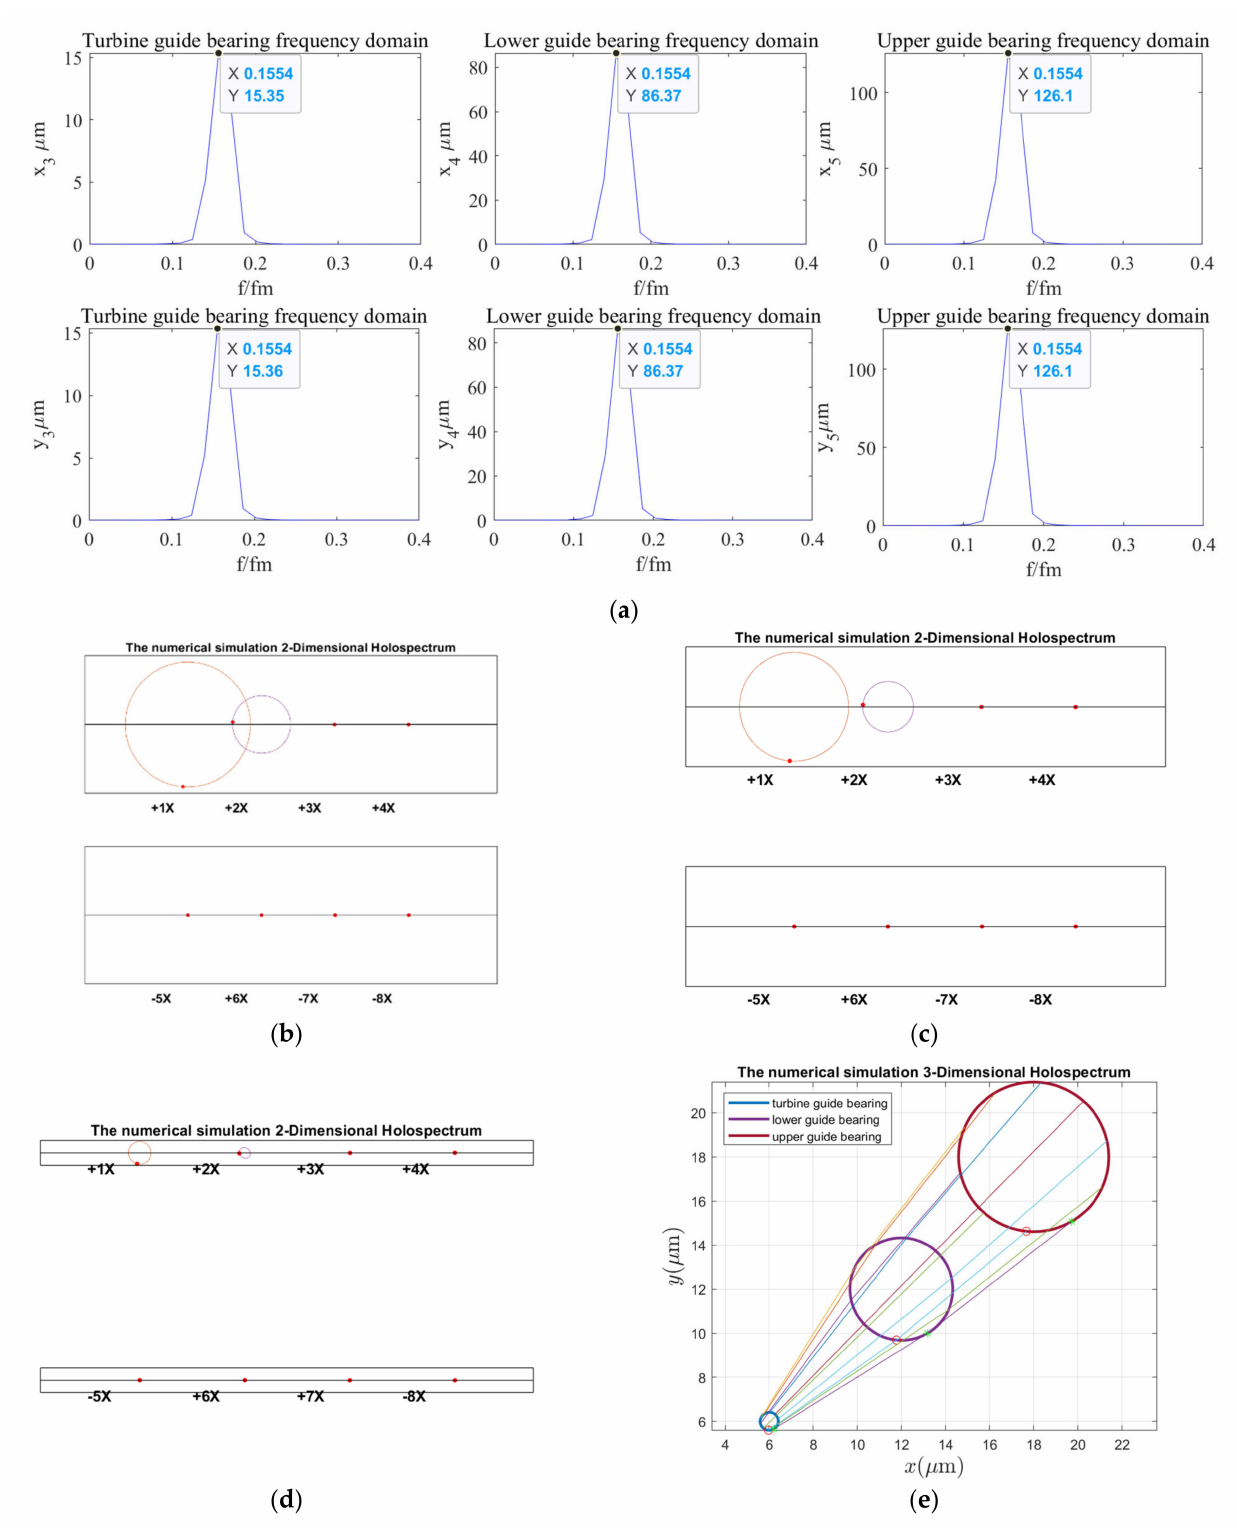
Figure 17. Holospectrum of shafting vibration of misaligned unbalance rotor, considering the oil film, RAW, rub, and UMP forces: ( a ) Shafting vibration spectrogram, ( b ) Upper guide bearing 2D holospectrum, ( c ) Lower guide bearing 2D holospectrum, ( d ) Hydro-turbine guide bearing 2D holospectrum, ( e ) One-fold frequency 3D